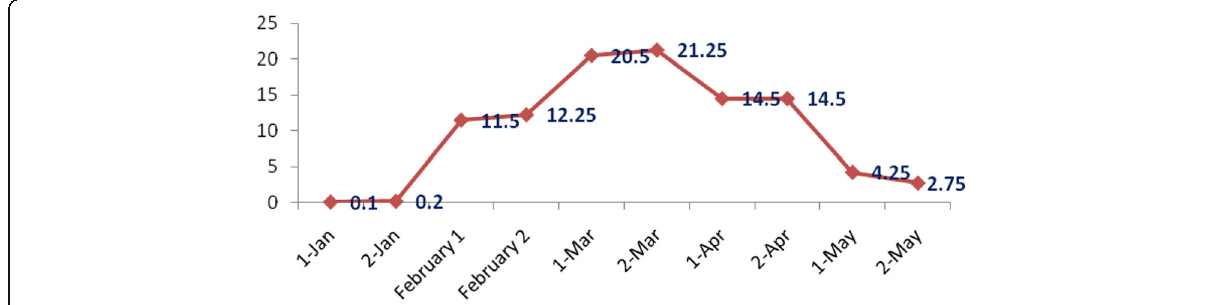
Fig. 1 Egg parasitization by Trichogramma chilonis recorded on eggs of H . armigera in berseem/trap cropping during